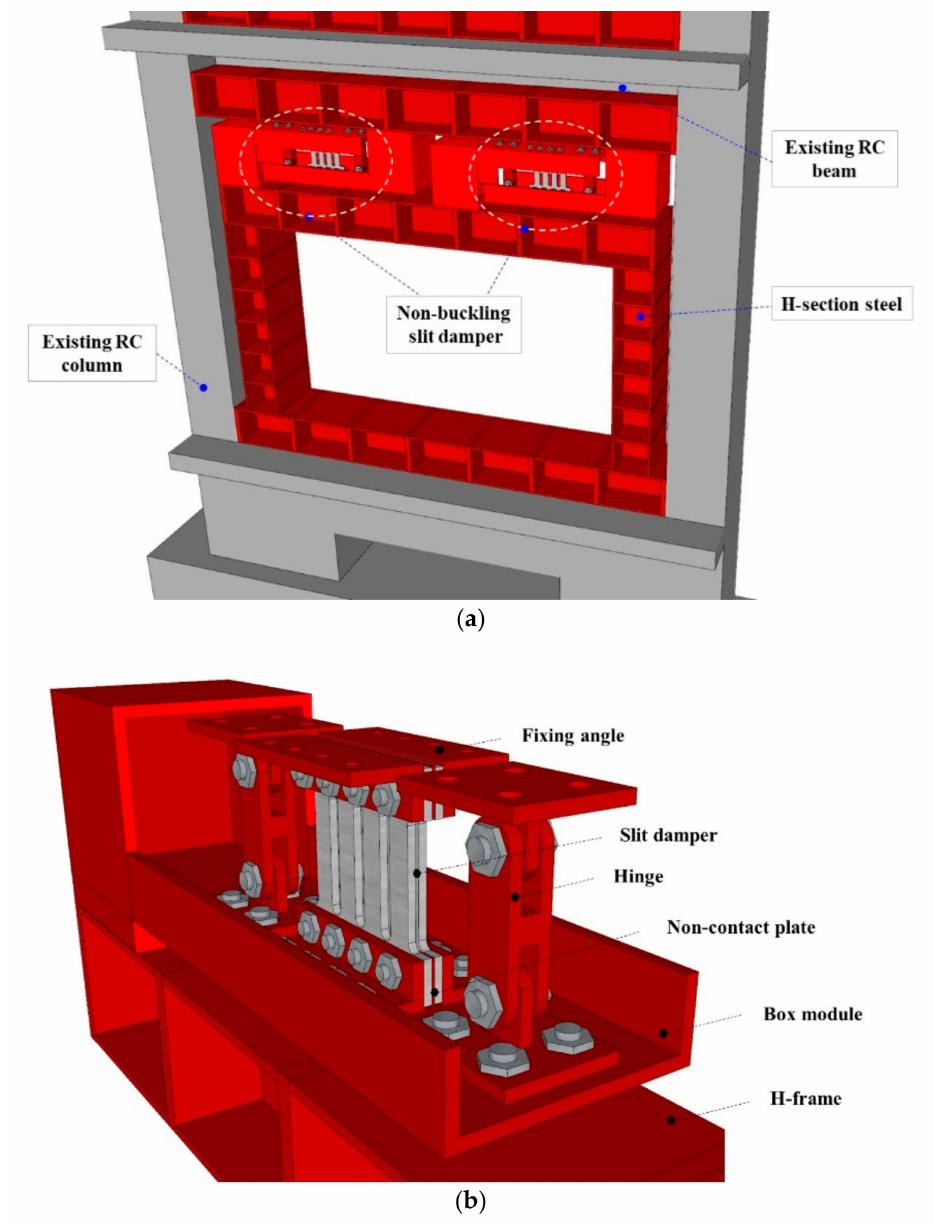
Figure 2. A schematic diagram of the window-type seismic control system using non-buckling slit dampers (NBSDs): ( a ) the window-type seismic control system, ( b ) components of the